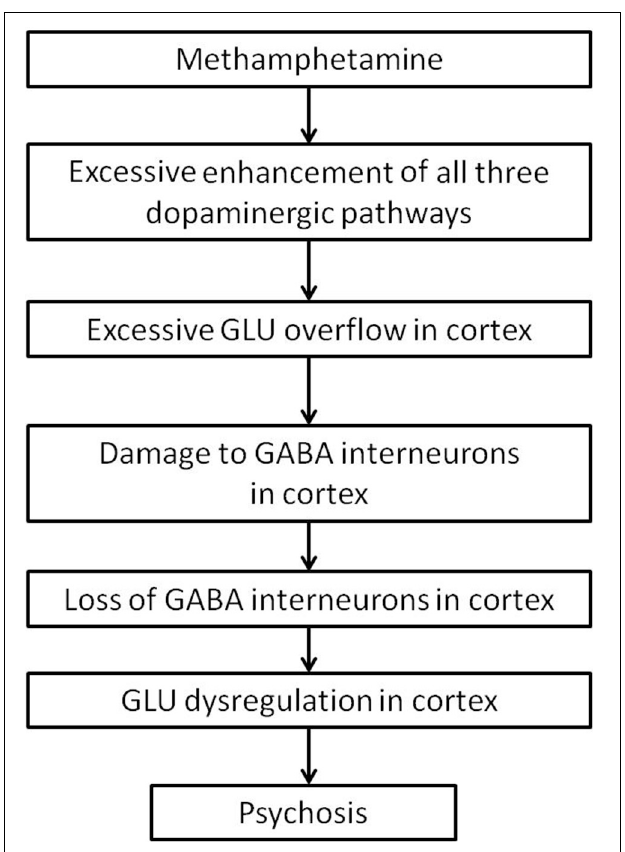
FIGURE 5 | Summary flow